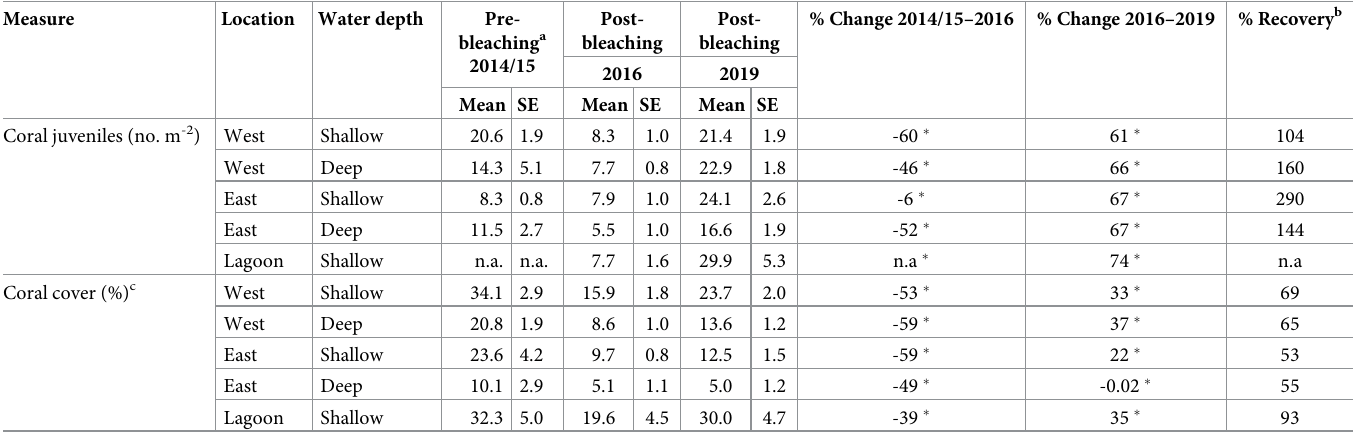
Table 1. Information on coral juvenile abundances and percentage hard coral cover at Aldabra between 2014 and 2019. Asterisks indicate significant differences between years; n.a. = not available.